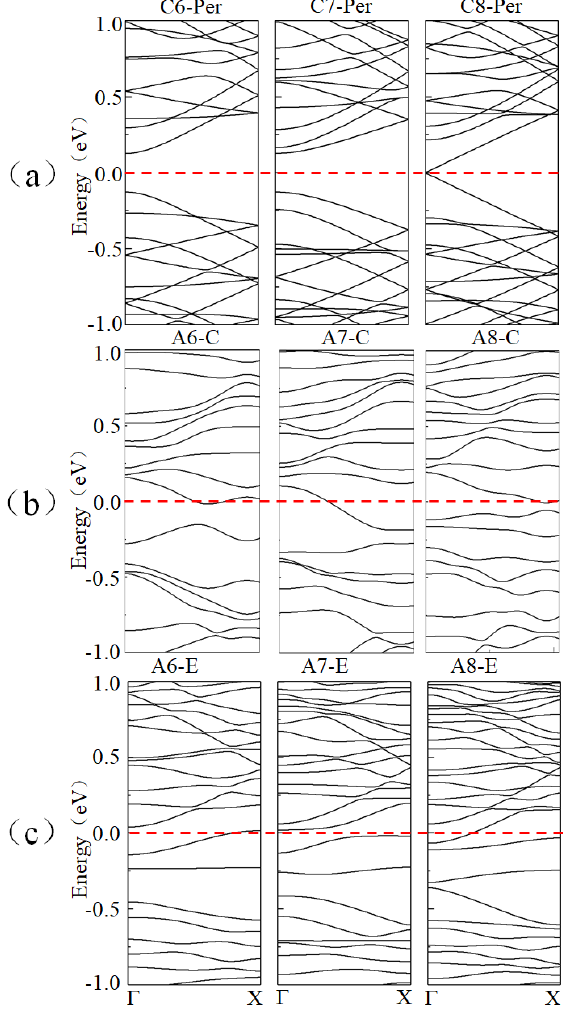
Figure 2. ( a – c ) The electronic band structures of original ASiNRs, AA-P 2 -central-doped ASiNRs, and AA-P 2 -edge-doped ASiNRs with widths of 6, 7, and 8 (N = 6, 7, and 8), respectively. The red dotted line is the Fermi energy level.